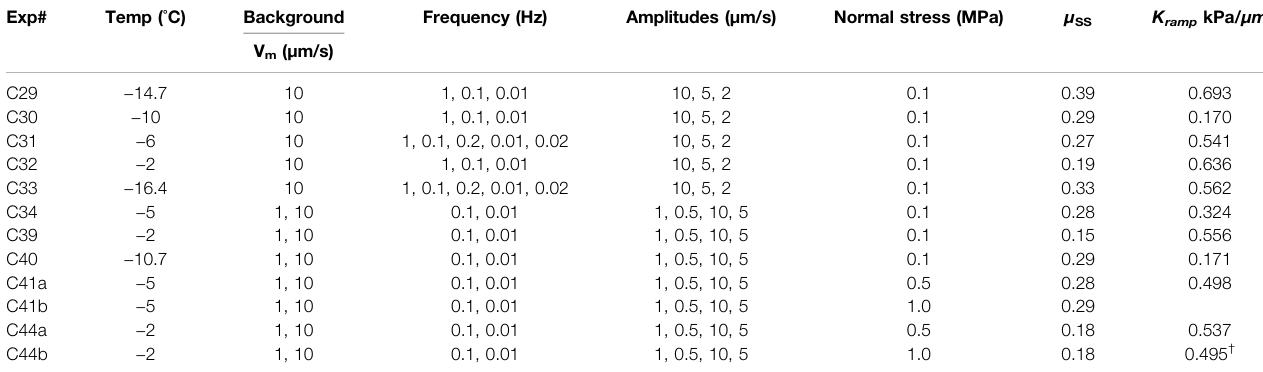
TABLE 1 | List of experiments, intended driving conditions*, steady-state friction measured at the end of the loading ramp, prior to oscillations, and run-in stiffness, K ramp (determinedfrom slopeoftheramp). The aand b runsforsamplesC41and C44representrunsat twodifferentnormal stresses onthesample,all otherconditionswere the same. † K ramp at 41b could not be measured because the system was not fully unloaded before the b run was initiated. *Fitted velocities were 1.1 and 11.1 μ